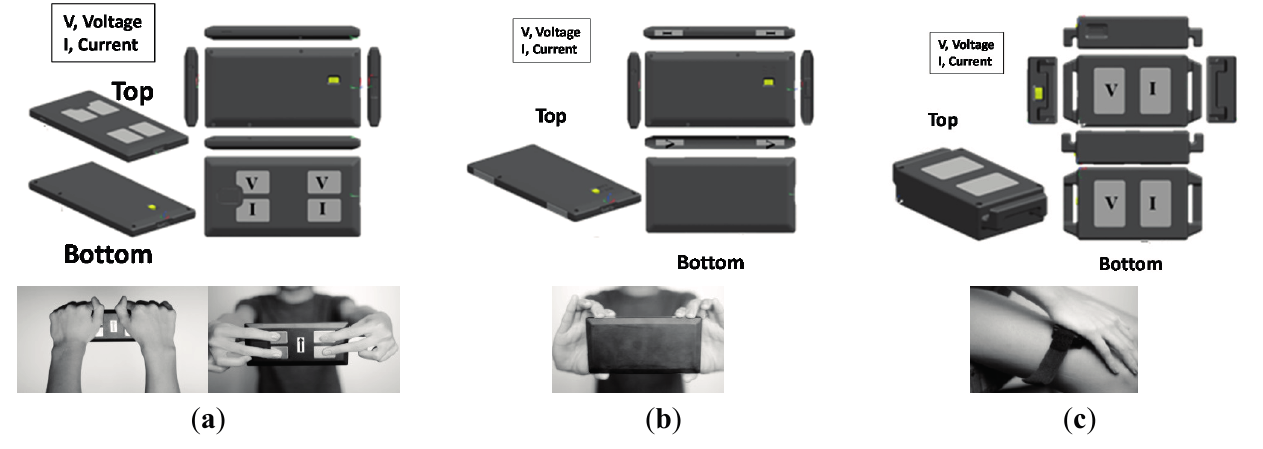
Figure 3. Three pathways of BIA devices ( a ) Palm-Palm (PP) type; ( b ) Finger-Finger (FF) type; and ( c ) Palm-Knee (PK)